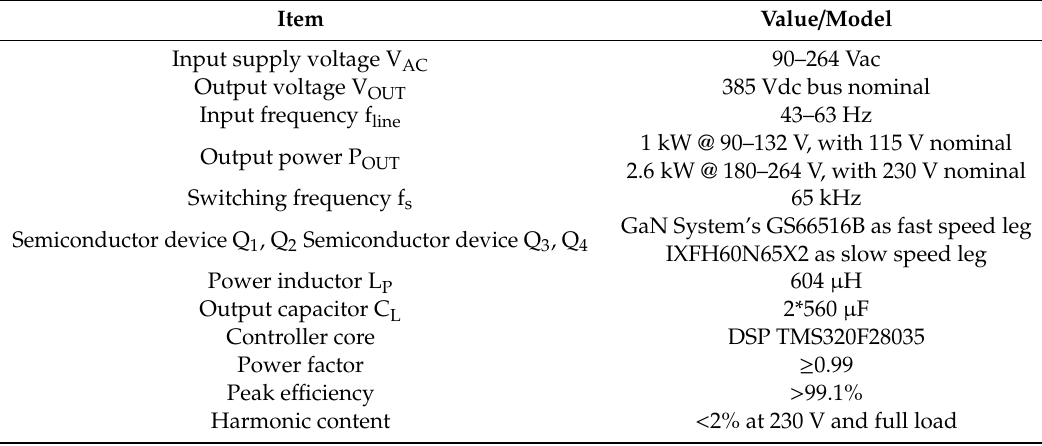
Figure 9. Perspective of the hardware prototype: ( a ) bird’s eye view; ( b ) top side view. Figure 10. Experimental waveforms of the totem-pole PFC rectifier running ( a ) at 230 VAC input and 2.6 kW output load; ( b ) at 115 VAC input and 1 kW output load (for both left and right figures: V AC 100 V/division, channel 1– I L 5 A/division, channel 2. Timebase 5 ms/division).